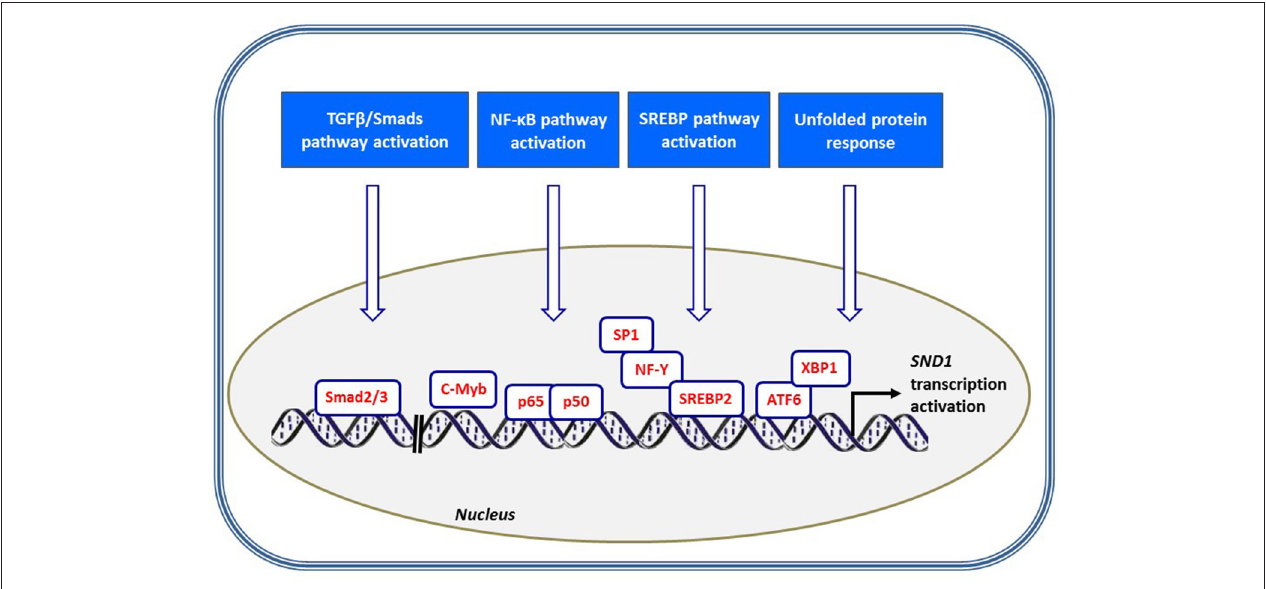
FIGURE 4 | Scheme illustrating the signaling pathways and transcription factors contributing to SND1 promoter activation. SND1 is transcriptionally upregulated by several stress settings, including TGF/Smads pathway through Smad2/3 binding, NF- κ B-mediated inflammation, SREBP activation concomitant to cholesterol depletion and ATF6/XBP1-mediated endoplasmic reticulum